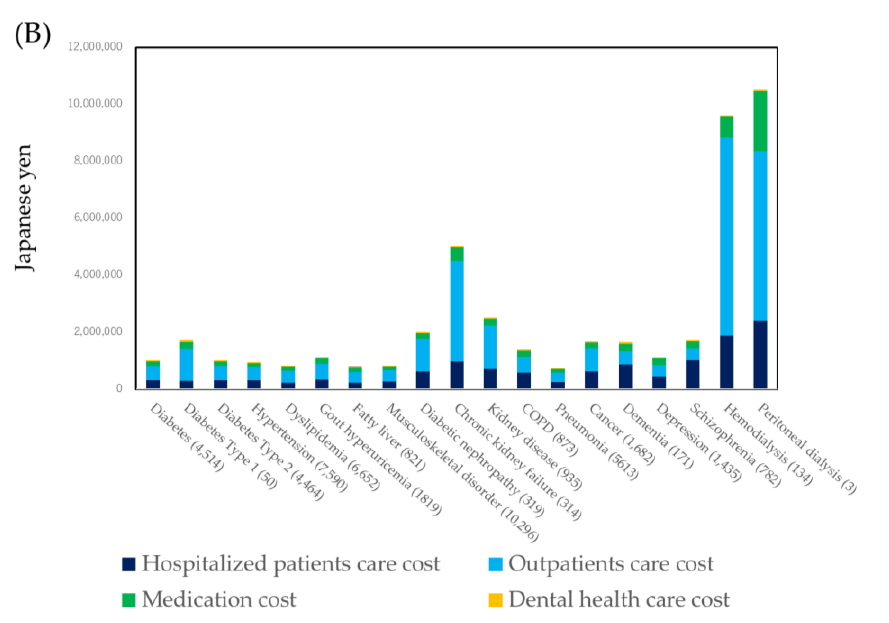
Figure 2. Healthcare cost of specific diseases. ( A ) Total healthcare cost, ( B ) healthcare cost per subjects.